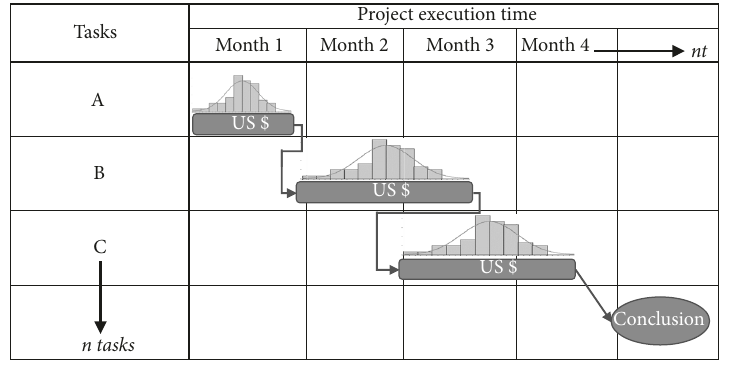
Figure 1: Diagram of a schedule with variable cost and